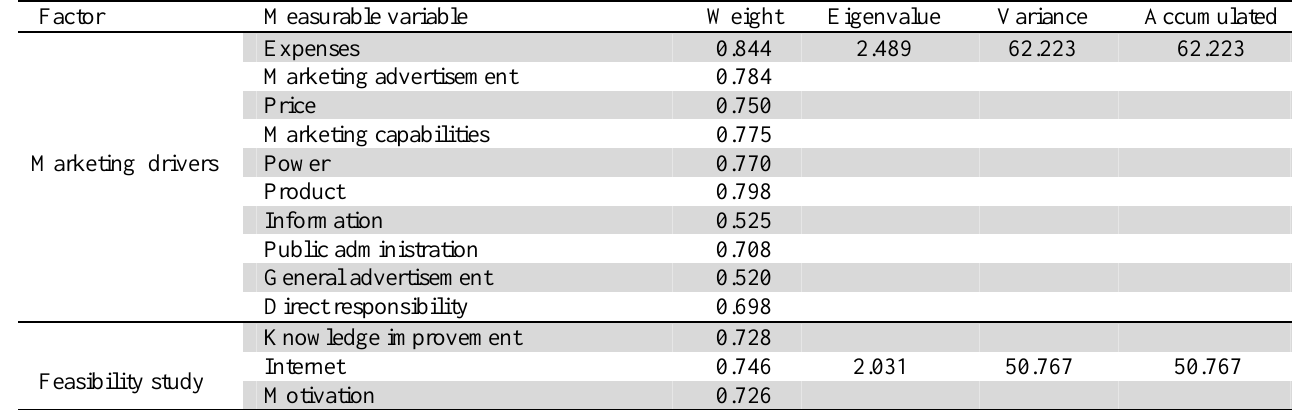
The summary of factor analysis